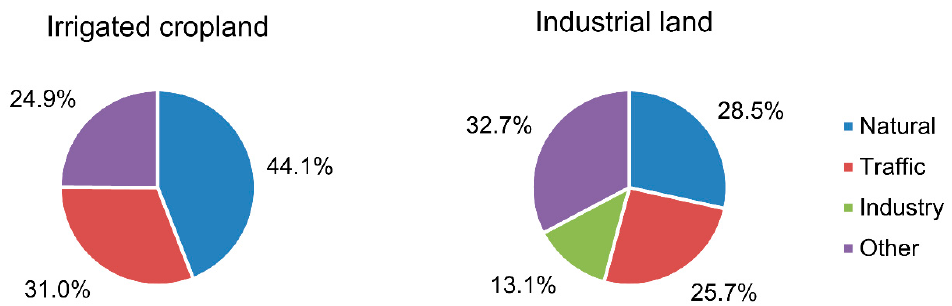
Figure 5. Pollution sources of heavy metals in soil using the PCA model.